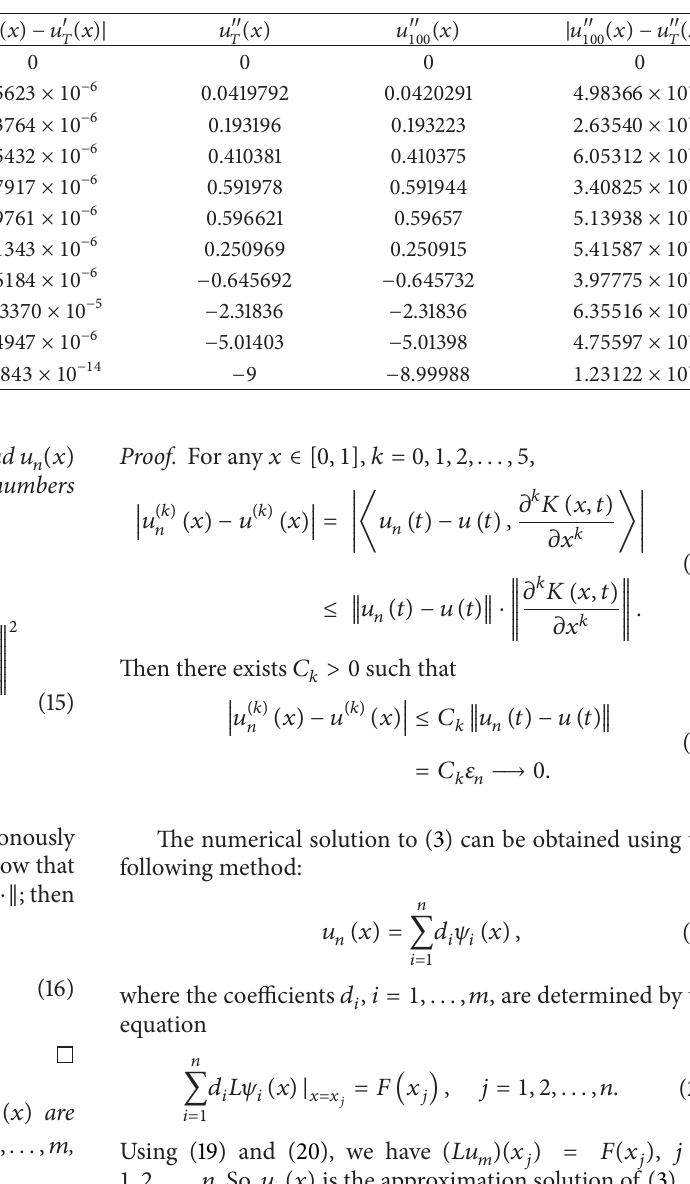
Table 3: The numerical results of Example